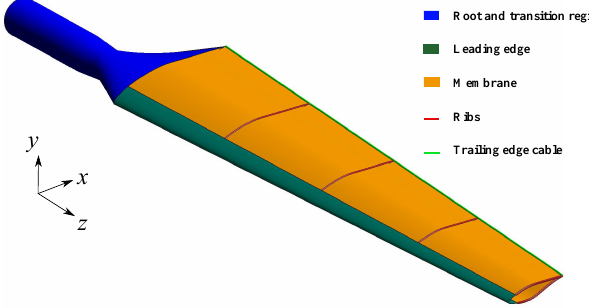
Figure 8. Solution procedure for the coupled problem.